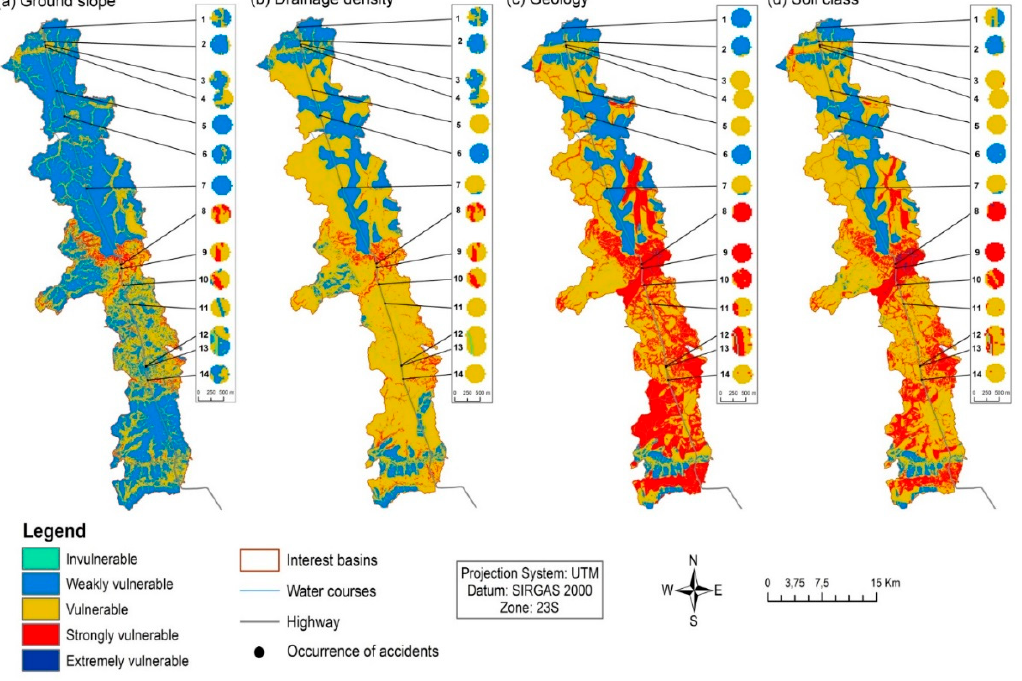
Figure 4. Vulnerability maps of the intercepted water course catchments, highlighting the vulnerability at the road accident sites (also termed hazard; labeled circles). The maps are outcomes of a Multi Criteria Analysis where vulnerability-relevant factors ground slope (map ( a )), drainage density ( b ), geology ( c ) and soil type ( d ) were given the largest weight [15]. The concomitant effects on vulnerability are reflexes of factor heterogeneity across the studied area. The largest effect occurs when factors geology or soil type are maximized highlighting the importance of these factors.